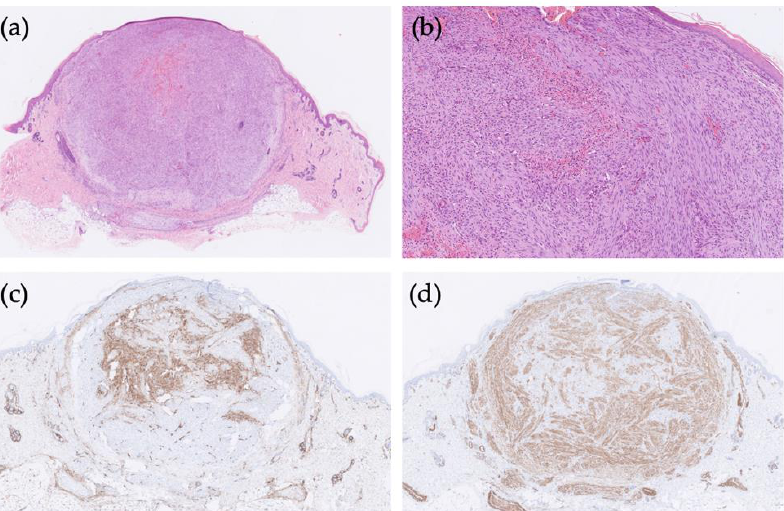
Figure 2. Histologic features of infantile myofibroma. The tumour shows a biphasic growth pattern with short fascicles of spindle cells surrounding centrally located round cells (hematoxylin-eosin [HE], ( a ) ×10, ( b ) ×100). Immunohistochemically, ( c ) round cells are positive for CD34, while ( d ) spindle myoid cells express smooth muscle actin (SMA).